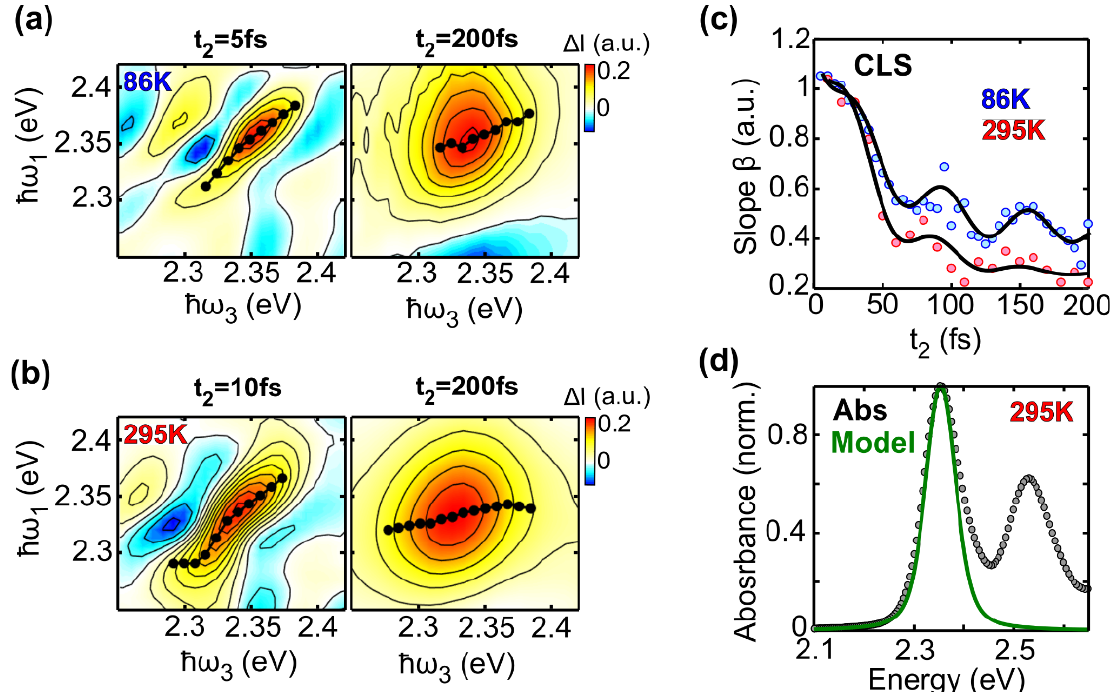
Figure 6. ( a ) Normalized purely absorptive 2DES maps around the absorption peak at 2.34 eV of LFO at t 2 = 5 fs and 200 fs for T = 86 K; the black dots are obtained using the CLS algorithm; ( b ) same as ( a ), for T = 295 K; ( c ) experimental CLS dynamics (symbols) overlapped with the best fit (continuum black lines) at 86 K (blue) and 295 K (red); ( d ) Experimental (black dots) and reconstructed (green line) absorption spectrum of the LFO transition peaked at 2.34 eV.